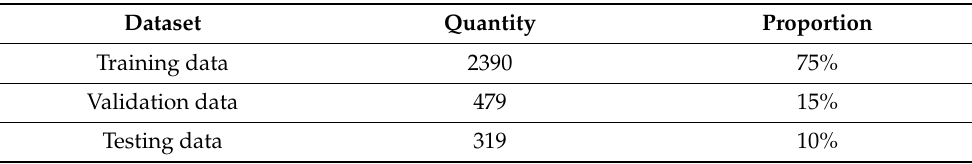
Table 1. Quantity and proportion of imported model